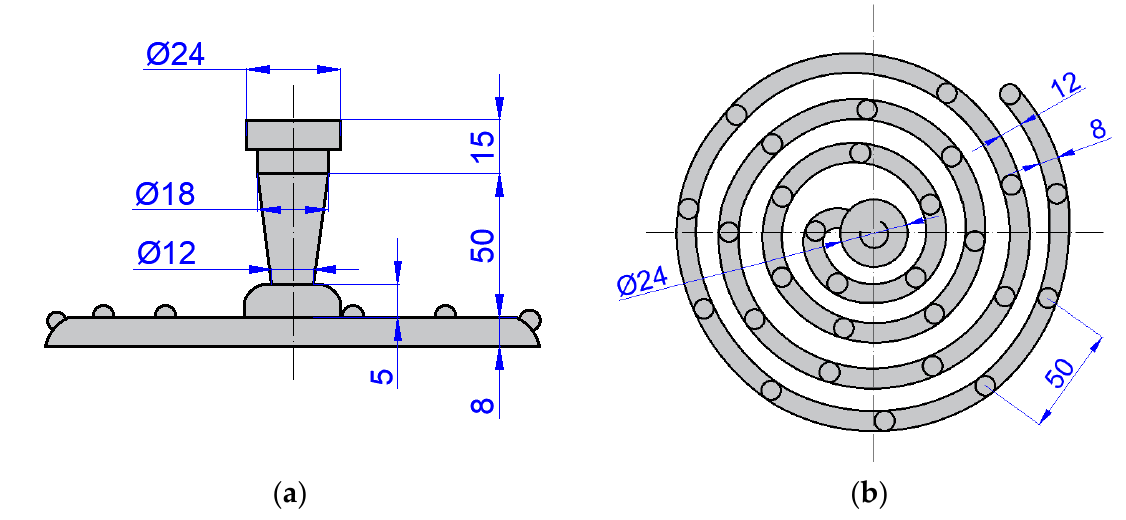
Figure 2. Scheme of spiral fluidity test (dimensions in mm): ( a ) front view and ( b ) top view. Table 4. Chemical composition of ZnAl4Cu3 alloy depending on the number of remelts.